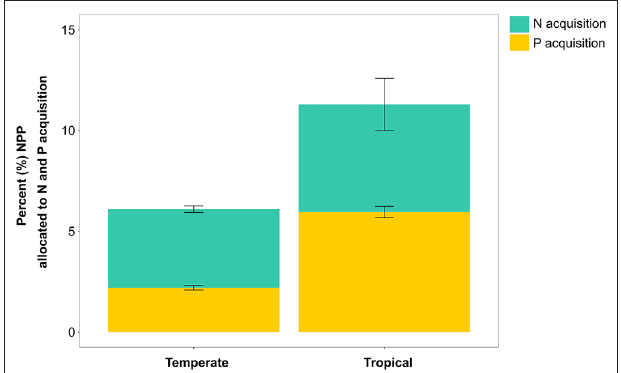
FIGURE 3 | Percent (mean ± SE) of NPP allocated to modeled N and P acquisition across temperate ( n = 45) and tropical ( n = 18) forest sites.